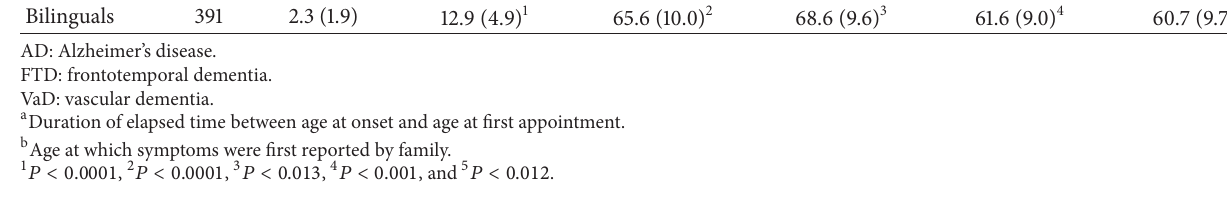
Table 3: Demographic measures and age at onset of symptoms of dementia and its subtypes in Indian study. Years of Group 𝑁 Duration a Monolinguals AD: Alzheimer’s disease. FTD: frontotemporal